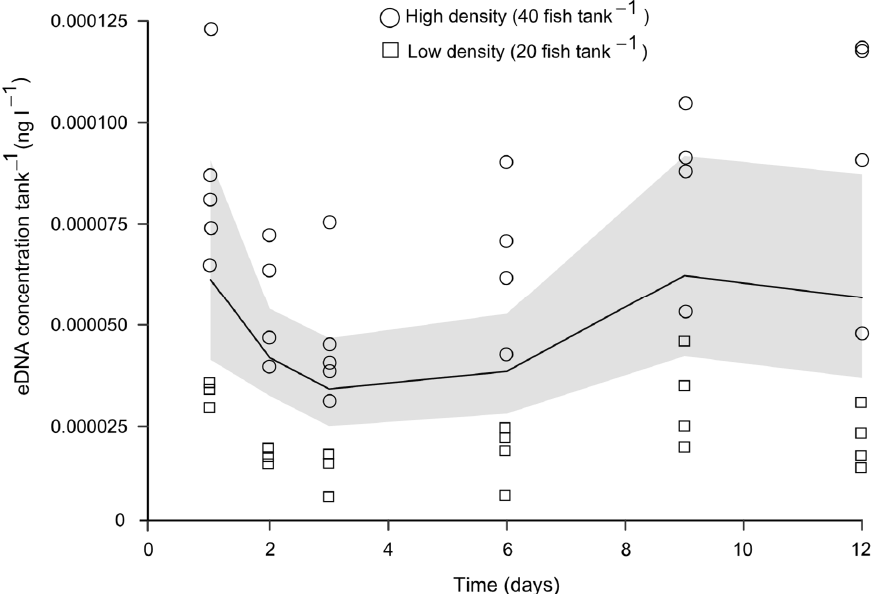
Figure 2. Relationship between eDNA concentration tank –1 and time of sampling assessed during experiment 1 completed at the Port Stephens Fisheries Institute, New South Wales, Australia during May, 2021. Data points reflect the raw data from high- and low-density tanks (open circles and squares), whereas solid and shaded lines indicate the generalised linear model fit and 95% confidence intervals, respectively, for the data irrespective of temperature.